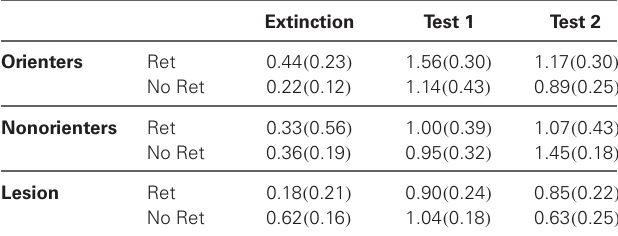
Table 1 | Mean ( ± SEM) orienting response during the last two trials